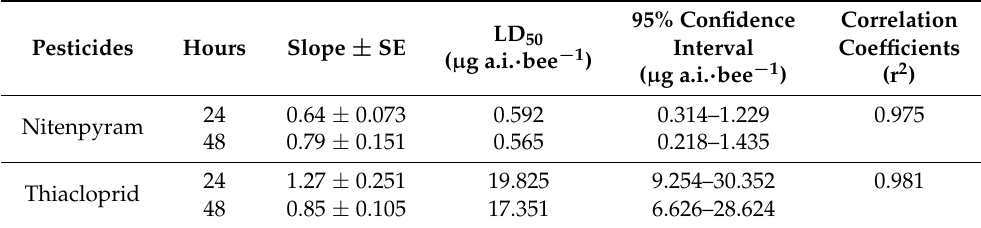
Table 2. Acute contact toxicity data of nitenpyram and thiacloprid tested on the B. terrestris .